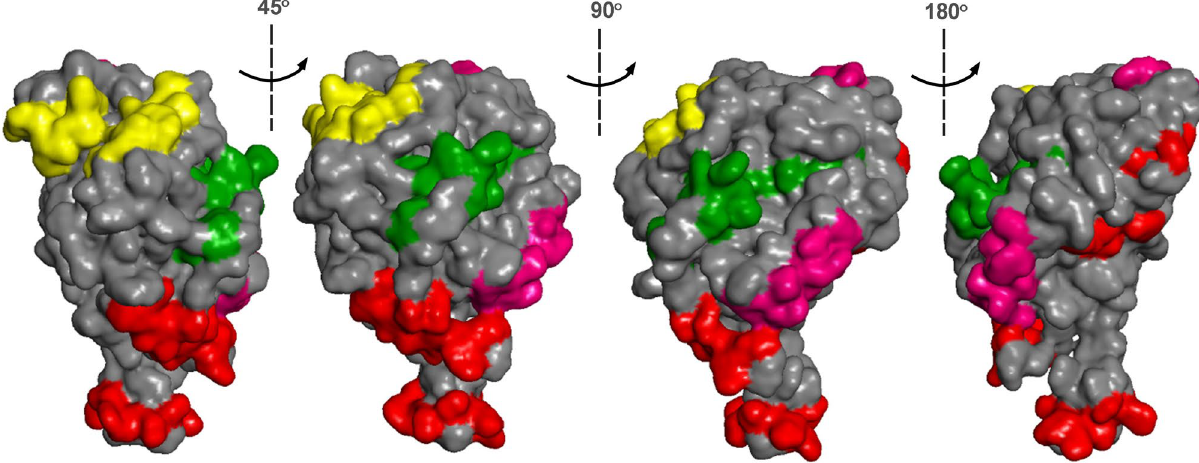
Figure 3. Spatial localization of the MAYV IgM linear epitopes in Dx-MAYV-M. A space-filling model of a computer-predicted structure for the multi-epitope chimeric protein with the core structure of the eGFP in gray along with the epitope of nsP1-20 in red, nsP2-10 in yellow, E1-8 in pink, and E2-11 in green. Multiple angles are